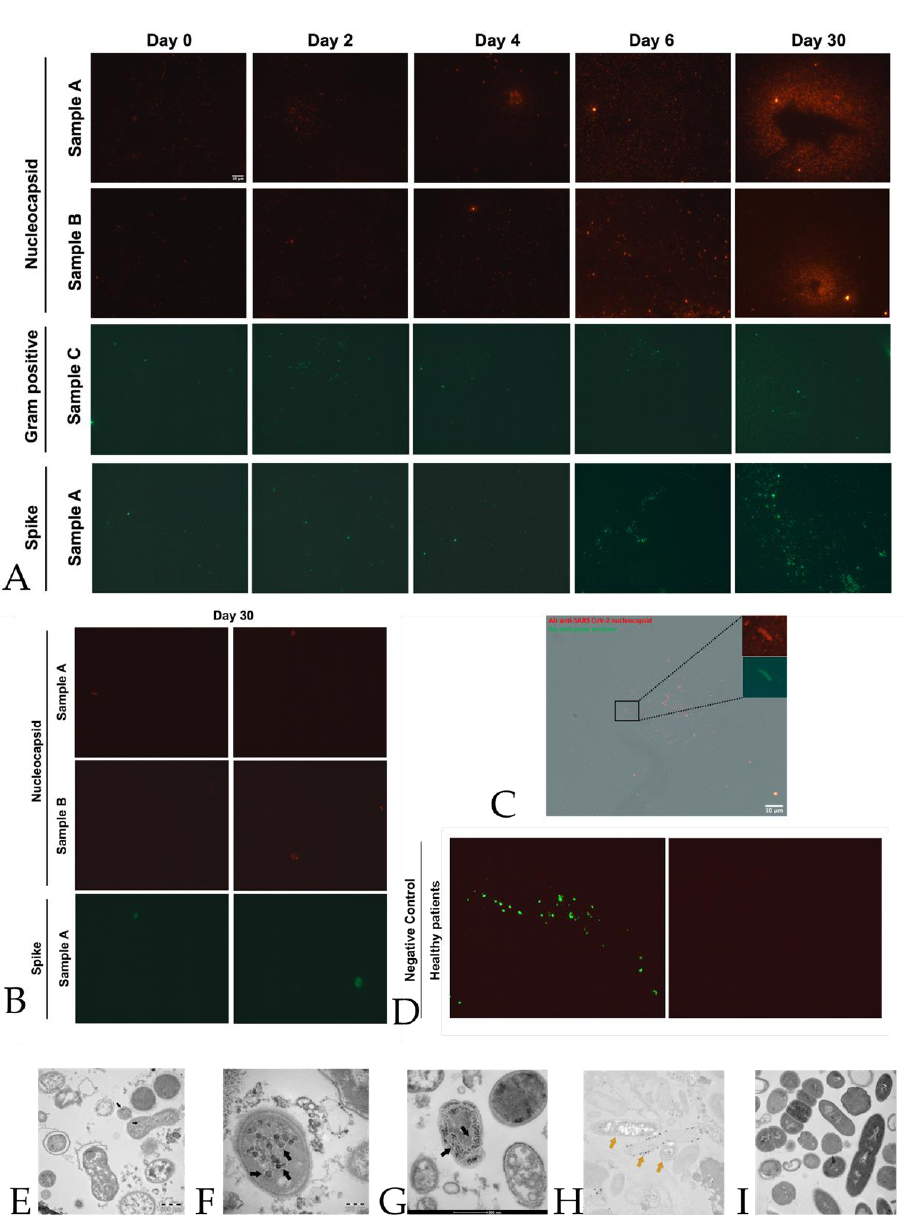
Figure 2. Quantification of SARS-CoV2 peptides by immunofluorescence . Panel A : Representa- tive panels show immunofluorescence of one sample among the ten samples A, B, and C of nucle- ocapsid, gram-positive, and spike proteins at 0, 2,4,6, and 30 days. Scale bar, 10 μ m. All the cases are presented in supplementary materials in Figures S1 and S2 . Panel B: Negative control of immu- nofluorescence of samples A and B at day 30 for nucleocapsid and spike proteins. Samples were incubated only with a secondary antibody; subsequently, no protein signal was detected. Panel C :